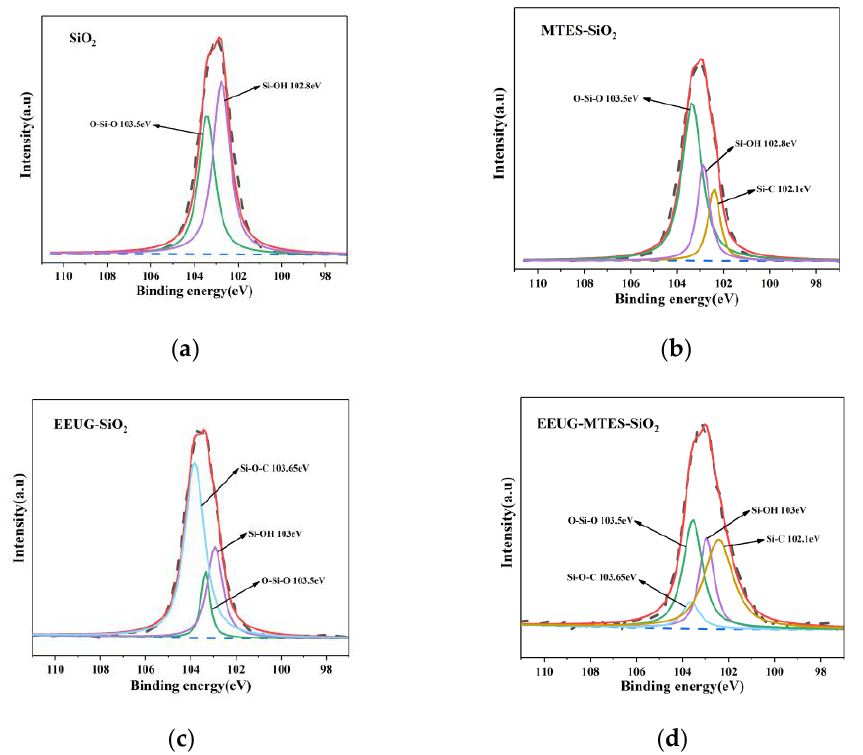
Figure 4. High-resolution XPS spectra of Si2p: ( a ) SiO 2 ; ( b ) MTES-SiO 2 ; ( c ) EEUG-SiO 2 ; ( d ) EEUG-MTES-SiO 2 .